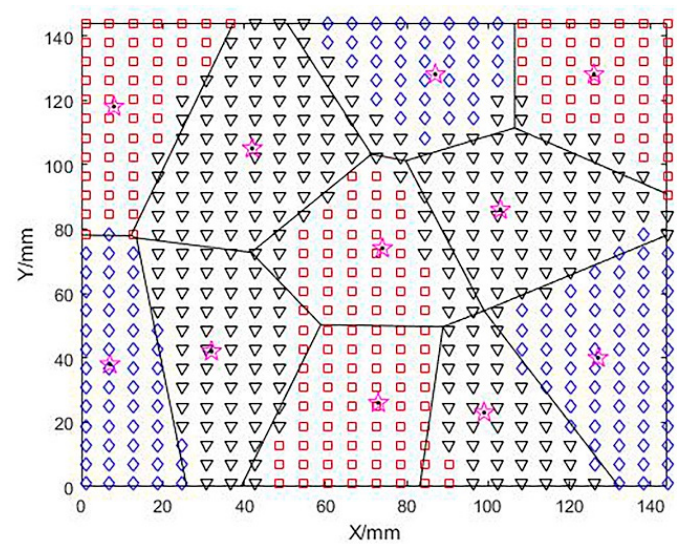
Figure 9. The result of boundary division of Voronoi diagram.